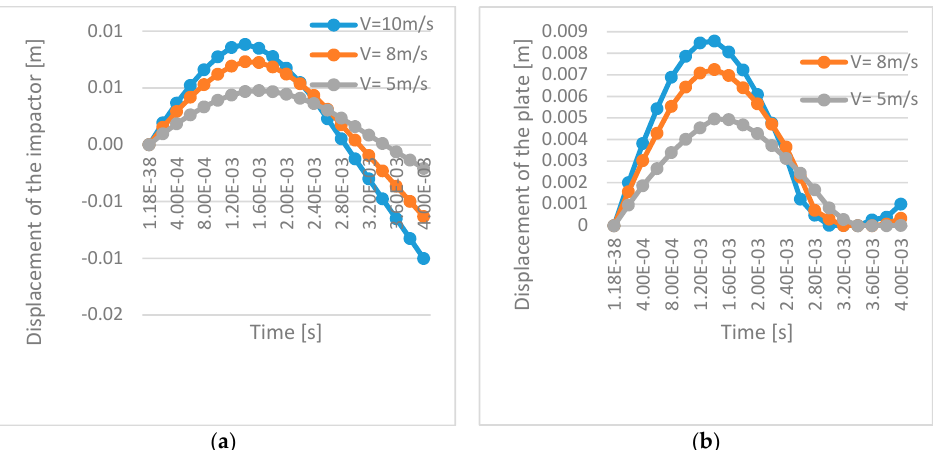
Figure 5. Variation of the displacement during impact ( a ) of the impactor and ( b ) of the WPC 10A plate.